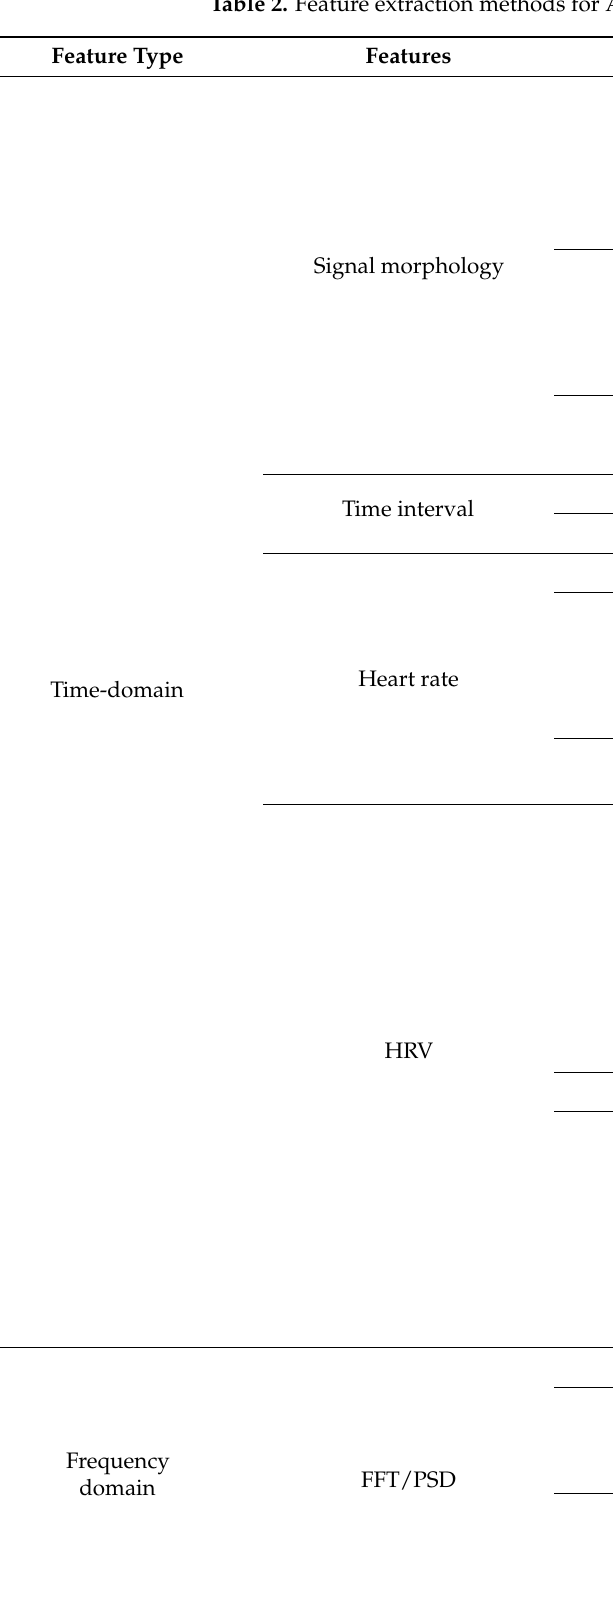
Table 2. Feature extraction methods for AF detection using cardiac dynamics